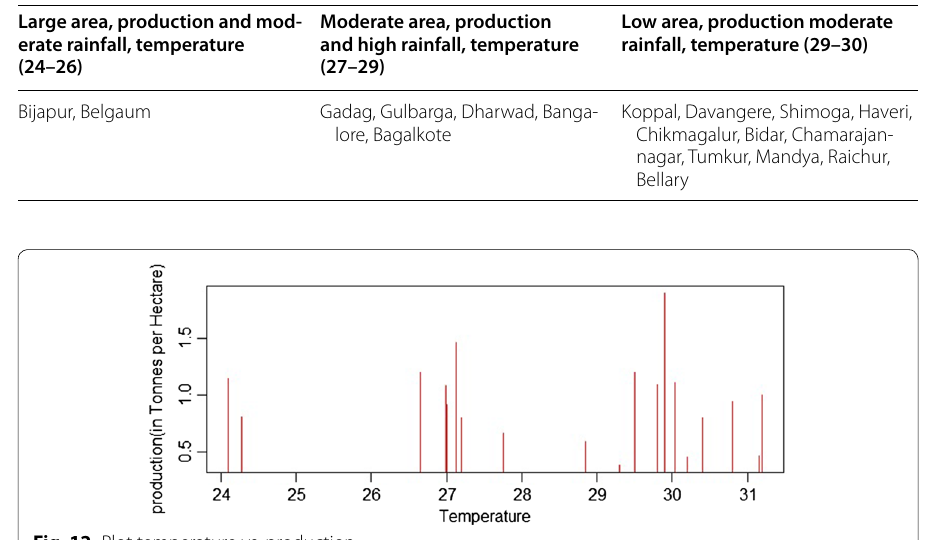
Fig. 12 Plot temperature vs. production